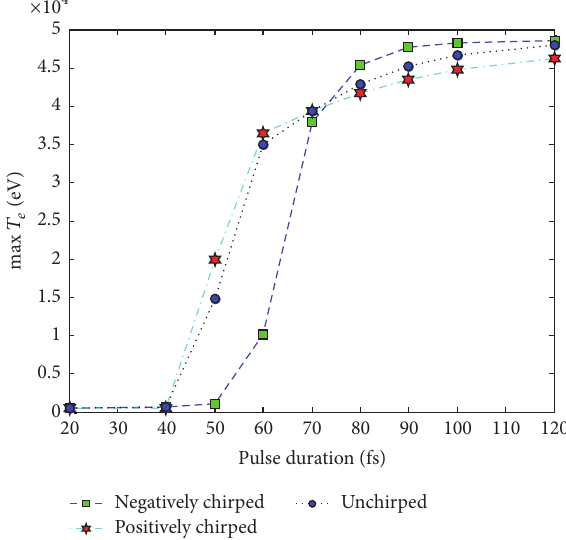
Figure 7: The variations in maximum energy of electrons at the positively and negatively chirped laser pulse as a function of pulse durations with 2 × 10 17 Wcm −2 laser intensity and wavelength of 825